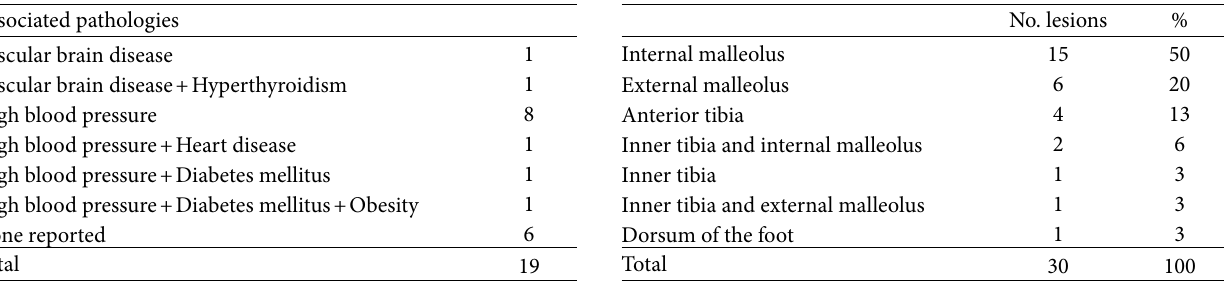
Table 3: Associated pathologies.